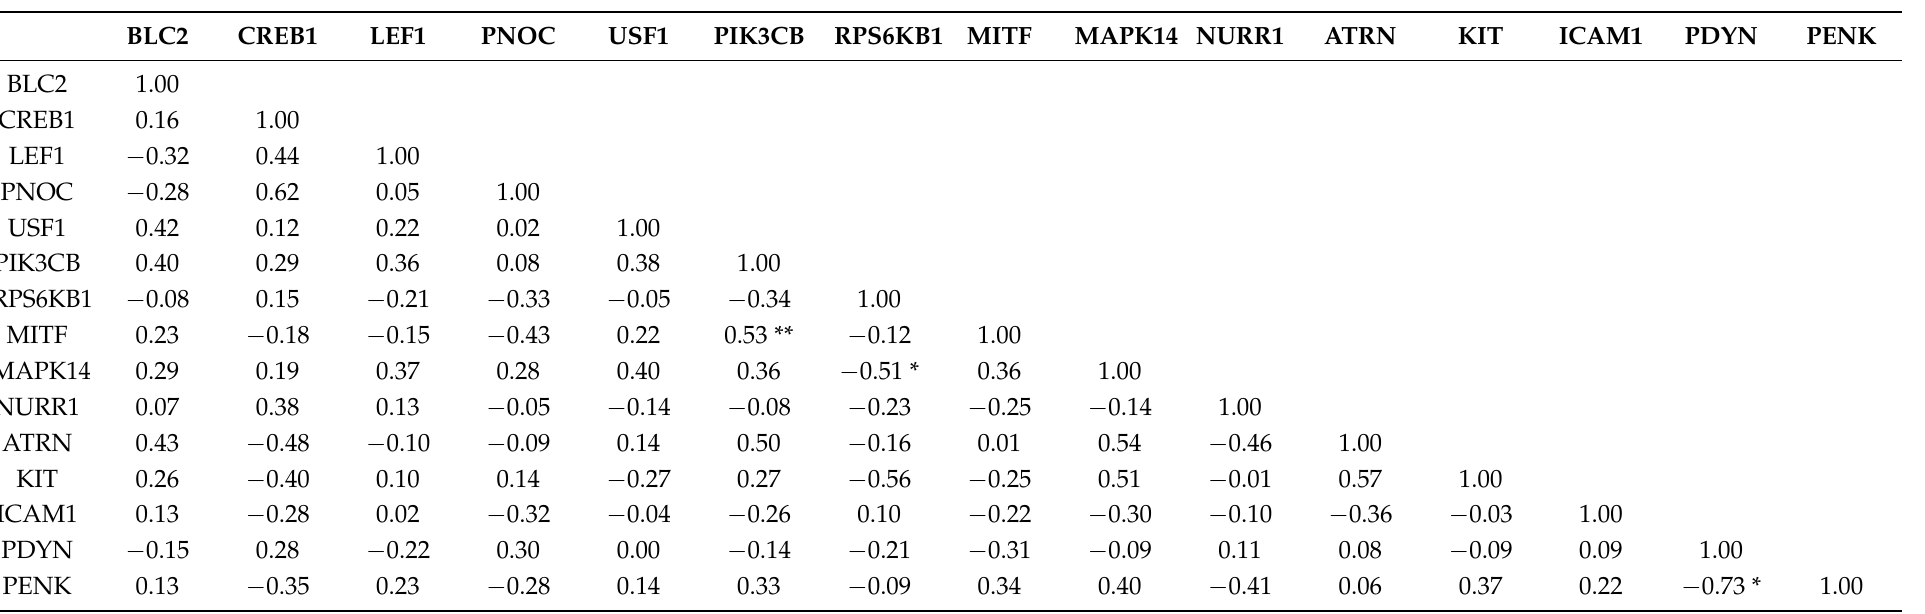
Table 3. Results of correlation analysis of gene expression in skin biopsies of healthy controls. Spearman rank correlation coefficient (Spearman r) was used. * p < 0.05; ** p <